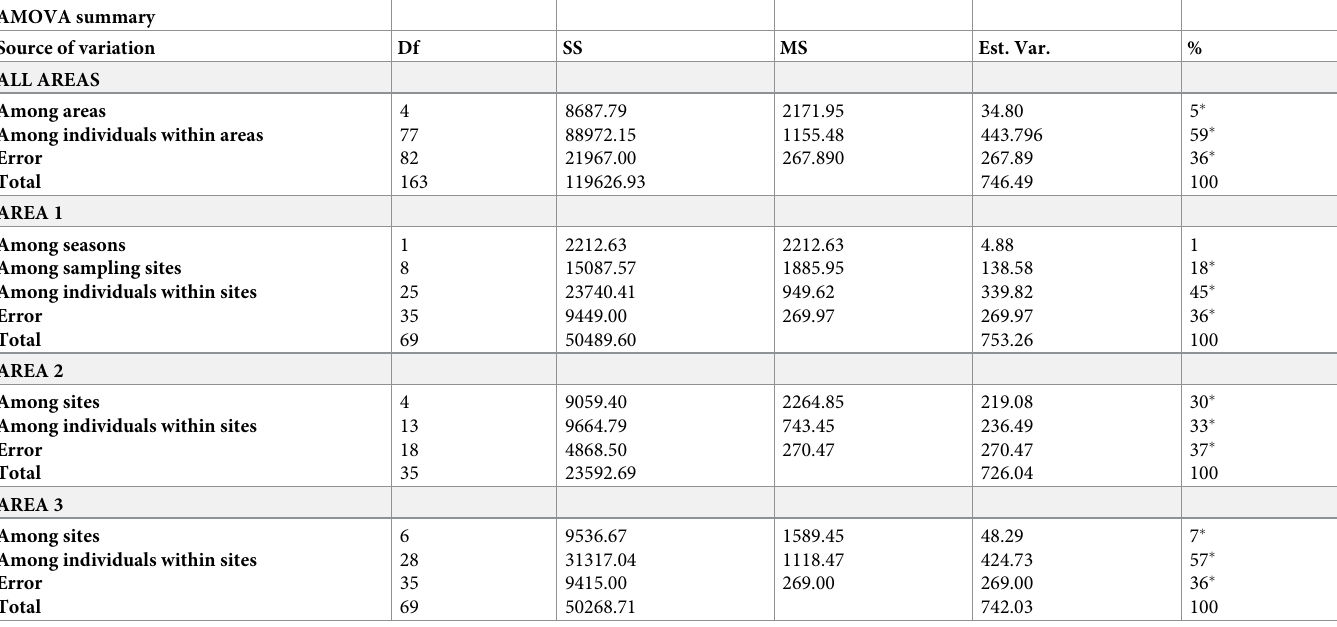
Table 2. Analysis of Molecular Variance (AMOVA) of Ae . aegypti samples from Buenos Aires and from each area within the city. AMOVA